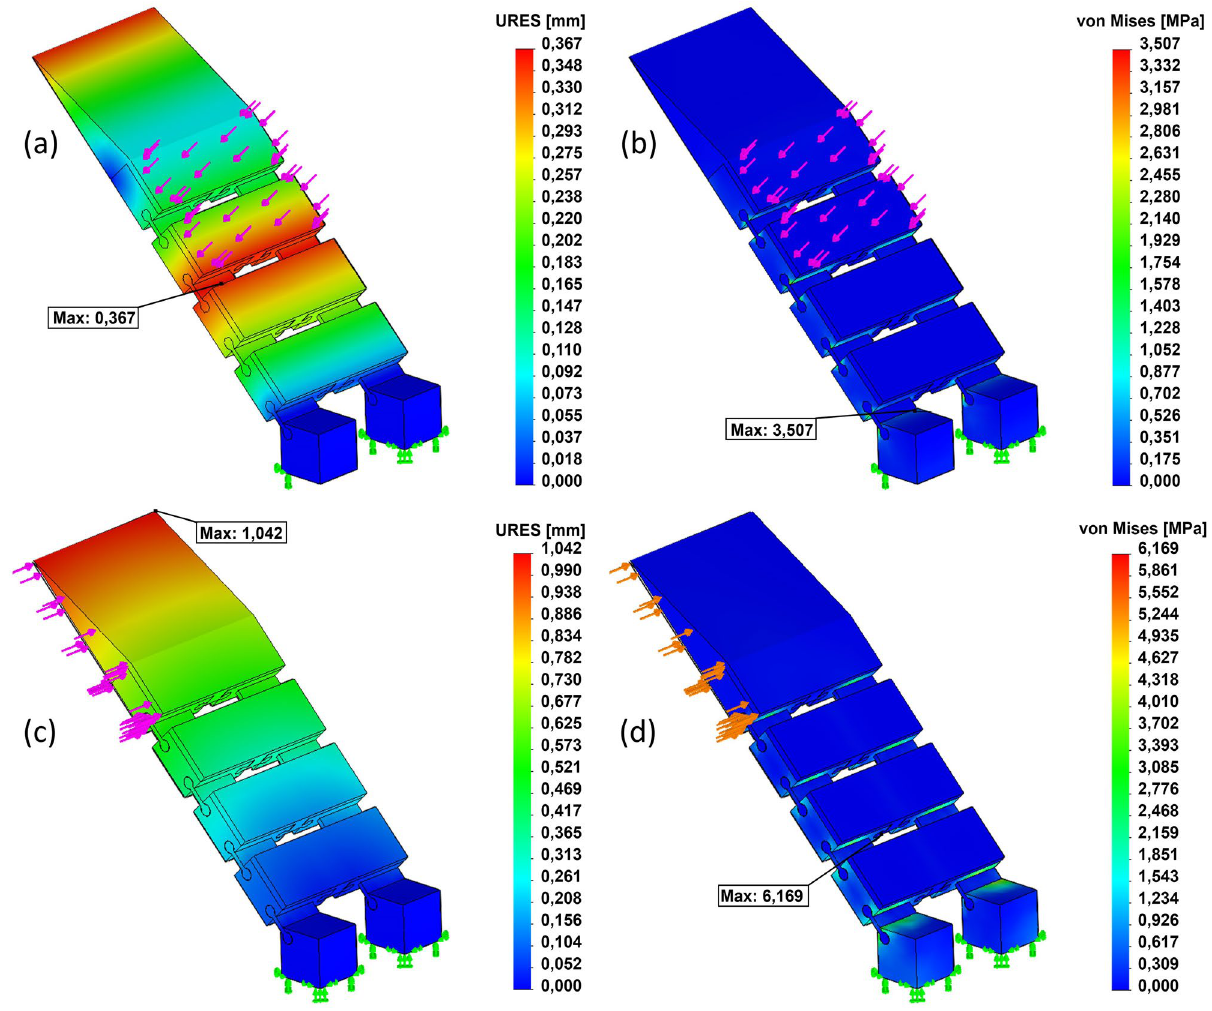
Fig. 10 PCL-PLA a displacement first configuration; b von Mises stress first configuration; c displacement second configuration; d von Mises stress second